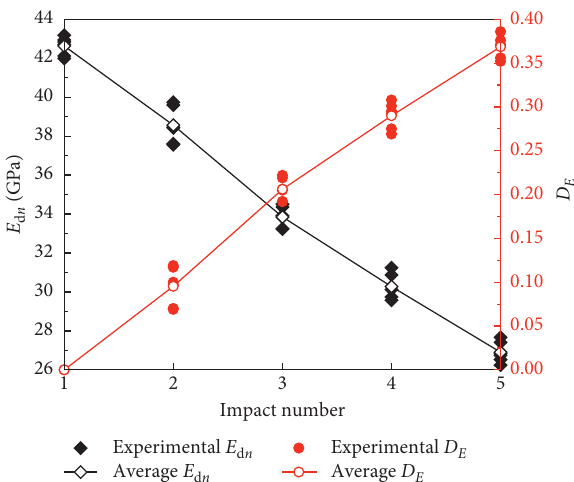
Figure 7: Variations in Edn and DE with impact